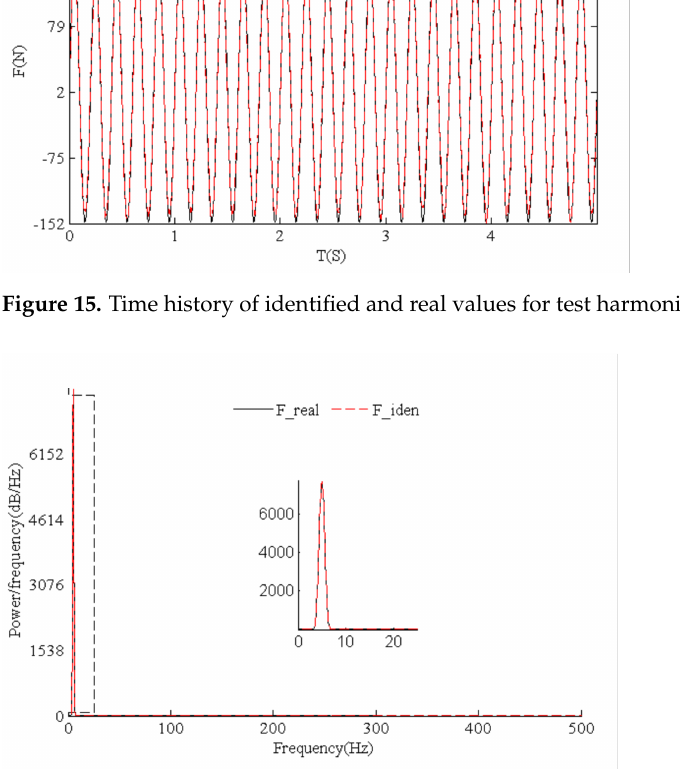
Figure 16. Identified and real PSDs for test harmonic loads.